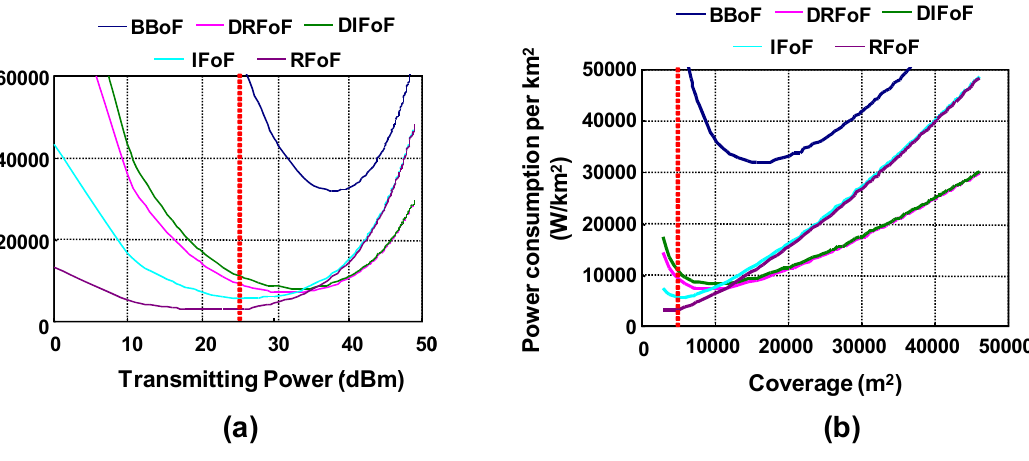
Figure 11. Power consumption per square km coverage for urban area for the five different transport schemes plotted as a function of ( a ) base station transmitting power and ( b ) cell size (With kind permission from Springer Science and Business